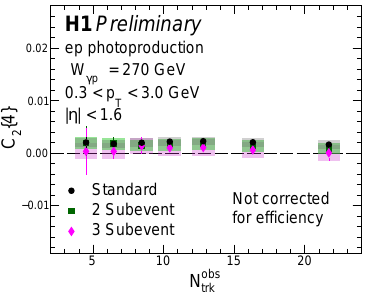
(cid:112) s = 319 GeV,